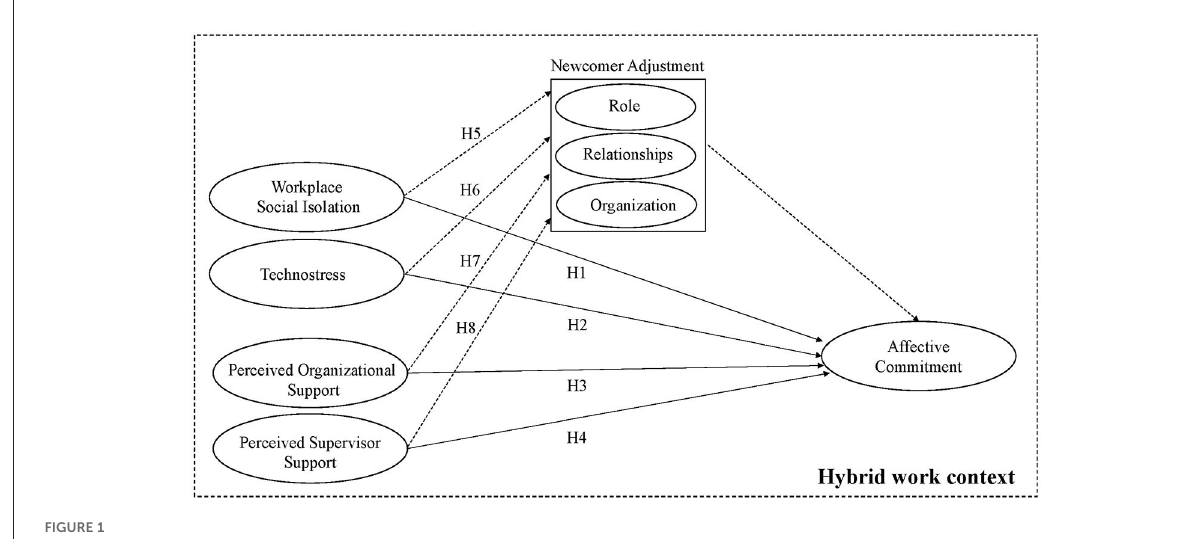
FIGURE1 Research